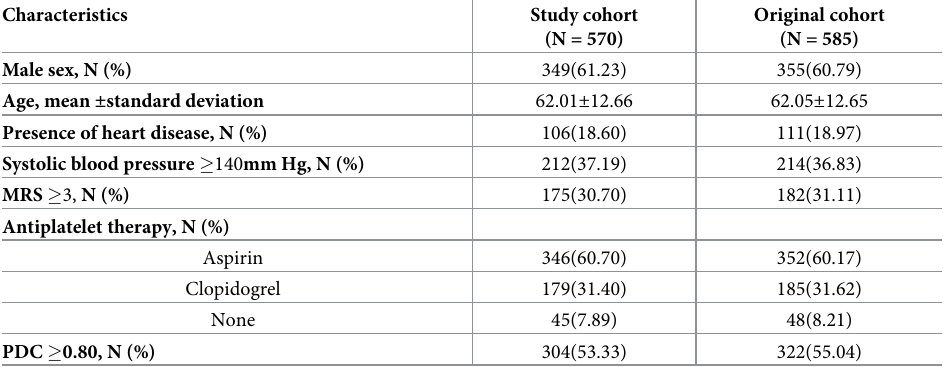
Table 2. Characteristics of the study cohort and original